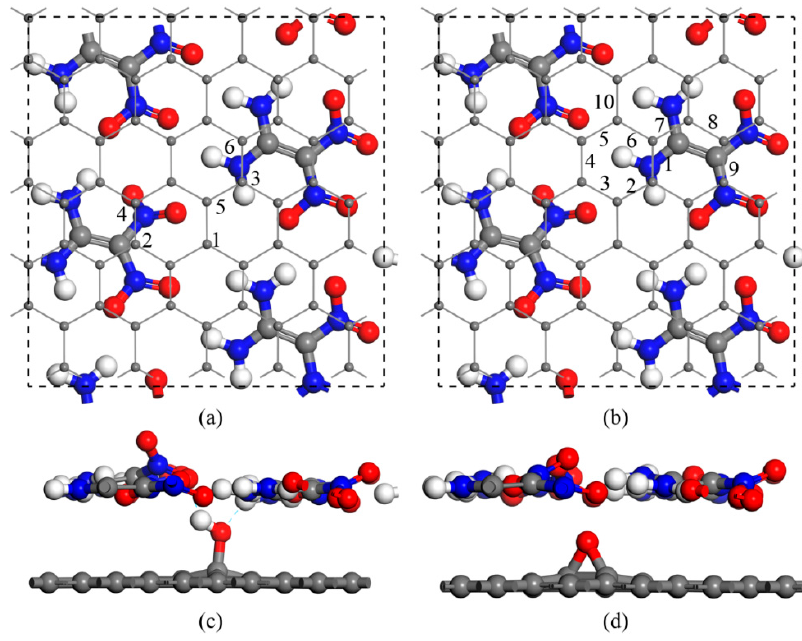
Figure 1. Schematic of the 1,1-Diamino-2,2-dinitroethylene–graphene oxide (FOX-7–GO) composites with di ff erent oxygen-containing groups on GO. ( a ) Top view for the six types of single hydroxyl group on GO. ( b ) Top view for the 10 types of single epoxy group on GO. ( c,d ) Side views of the two stable configurations. Gray, red, and white balls represent carbon, oxygen, and hydrogen atoms, respectively.